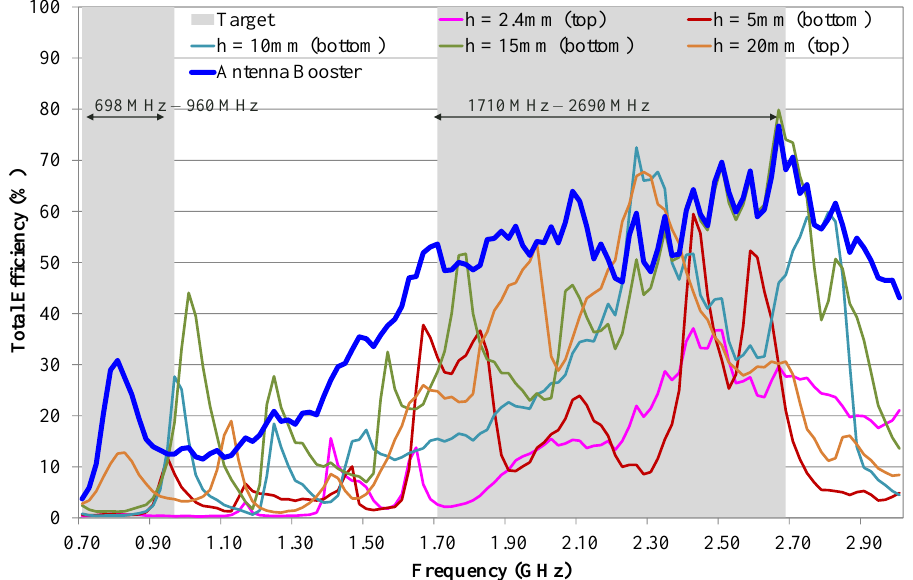
Figure 13. Measured total efficiencies for the antenna booster and the FPC. The best efficiency among